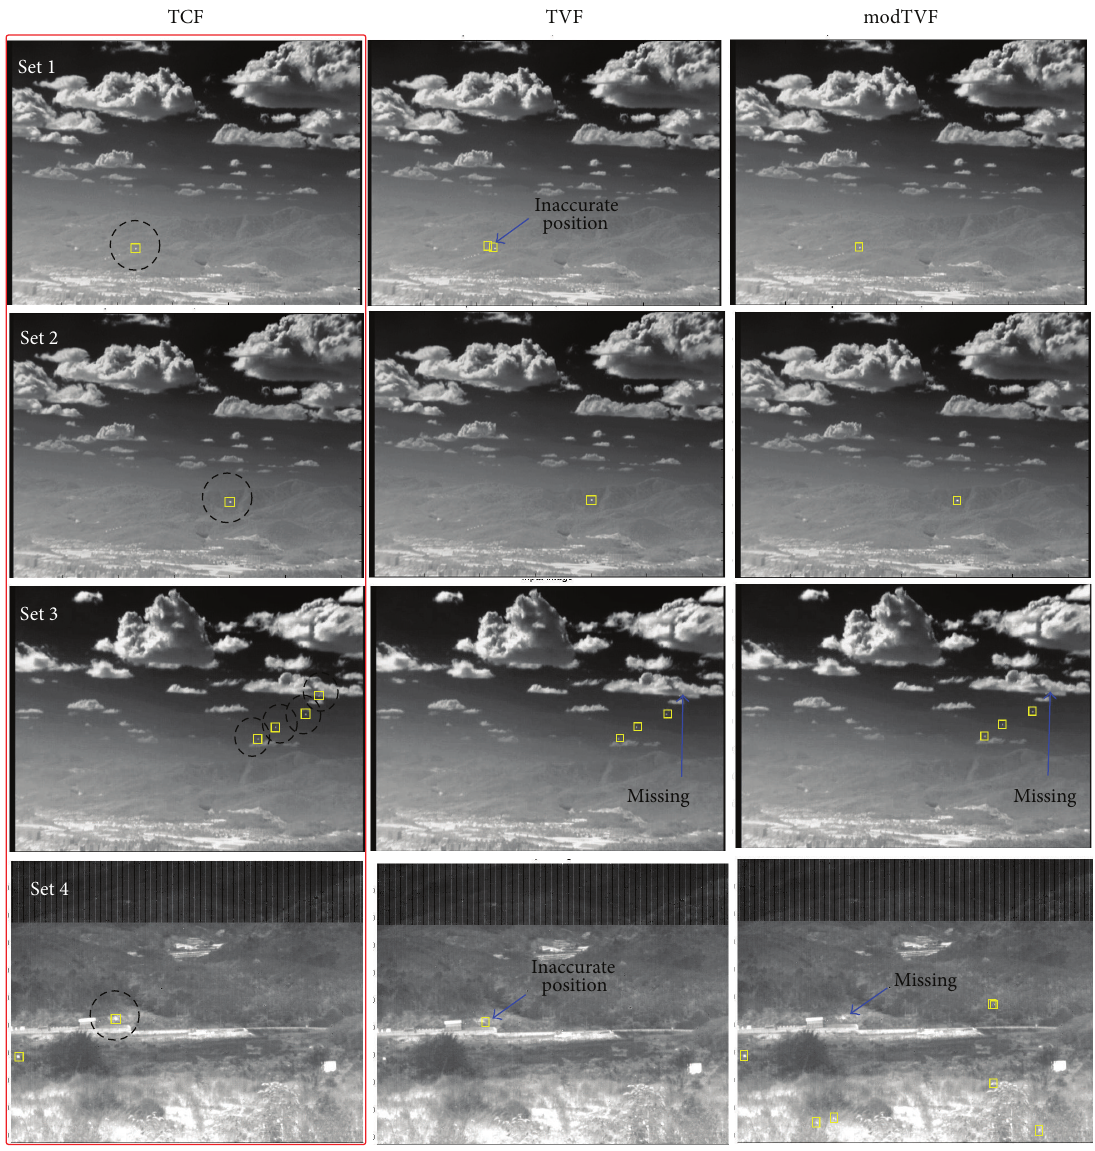
Figure 19: Performance comparison examples of small target detection methods for the four kinds of test sets. Circles represent ground truth and rectangles represent detected results. Table 5: Statistical performance comparisons of small infrared target detection methods (DR: detection rate, FAR: number of false alarms per frame, PE: position